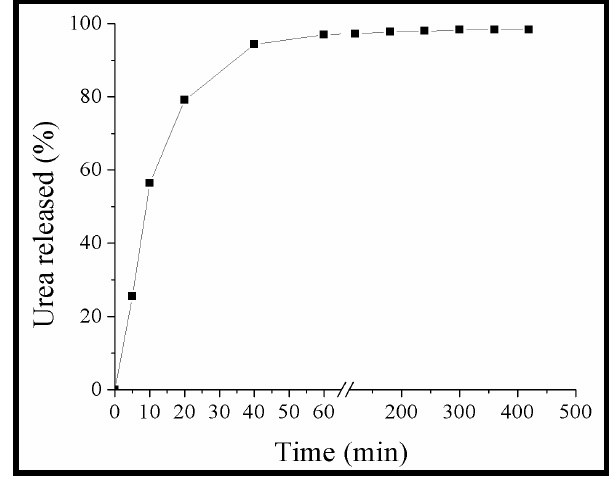
Figure 4. Release kinetics of urea in water at 25 °C from pastille composed of WG membranes loaded with